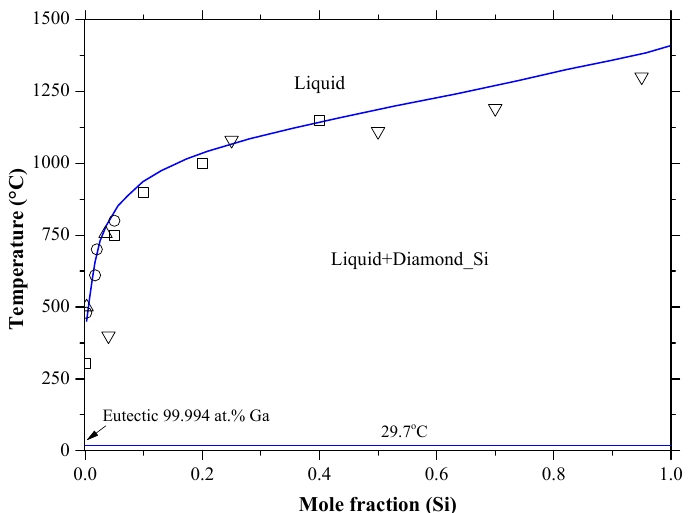
Figure 18. The Ga-Si phase diagram [185]; □ : [186]; Δ : [188]; : [187]: ○ : [178].